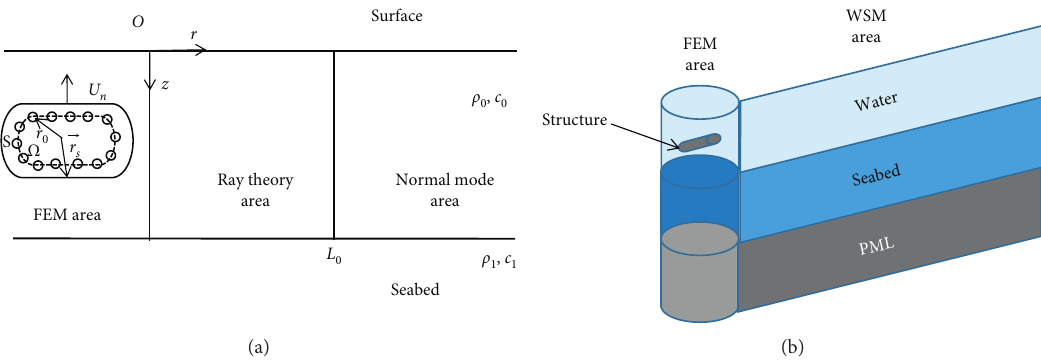
Figure 2: (a) Principle of combined wave superposition method in a shallow water waveguide. (b) Model of a cylindrical shell sound radiation based on CWSM.